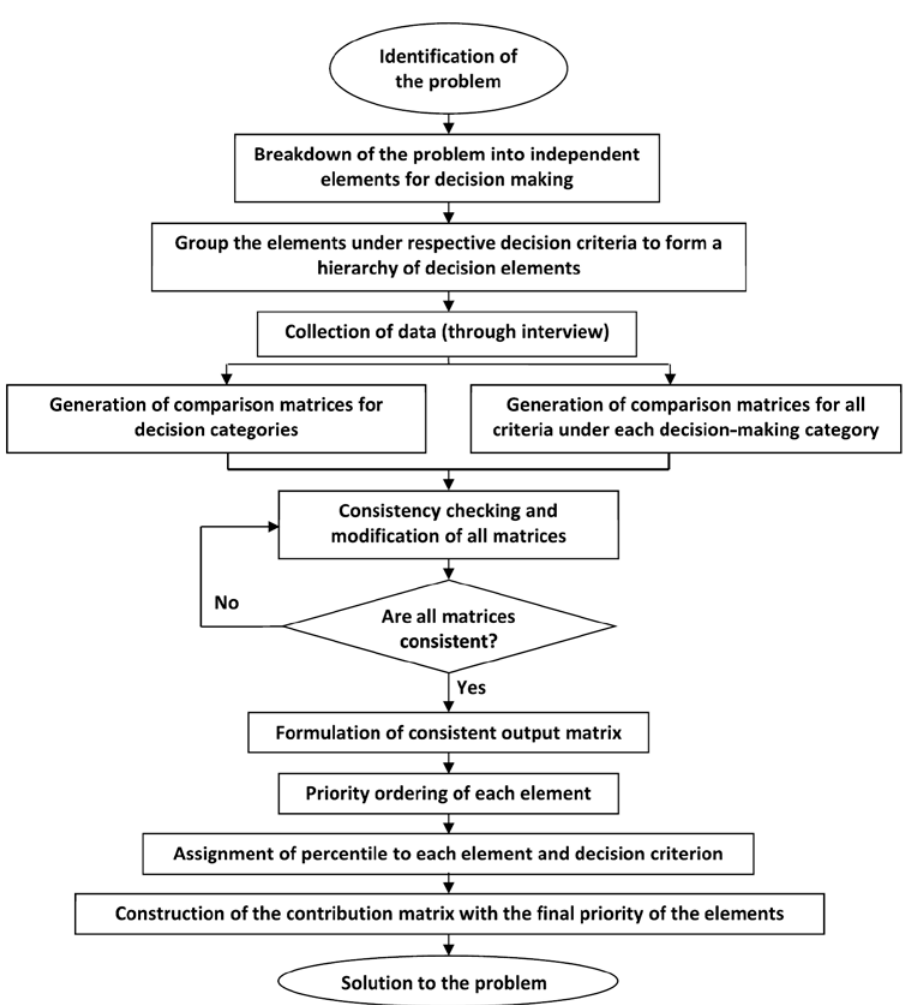
Fig. 3. Work flow of the non-structural fuzzy decision support system (NSFDSS) (adapted from Yau